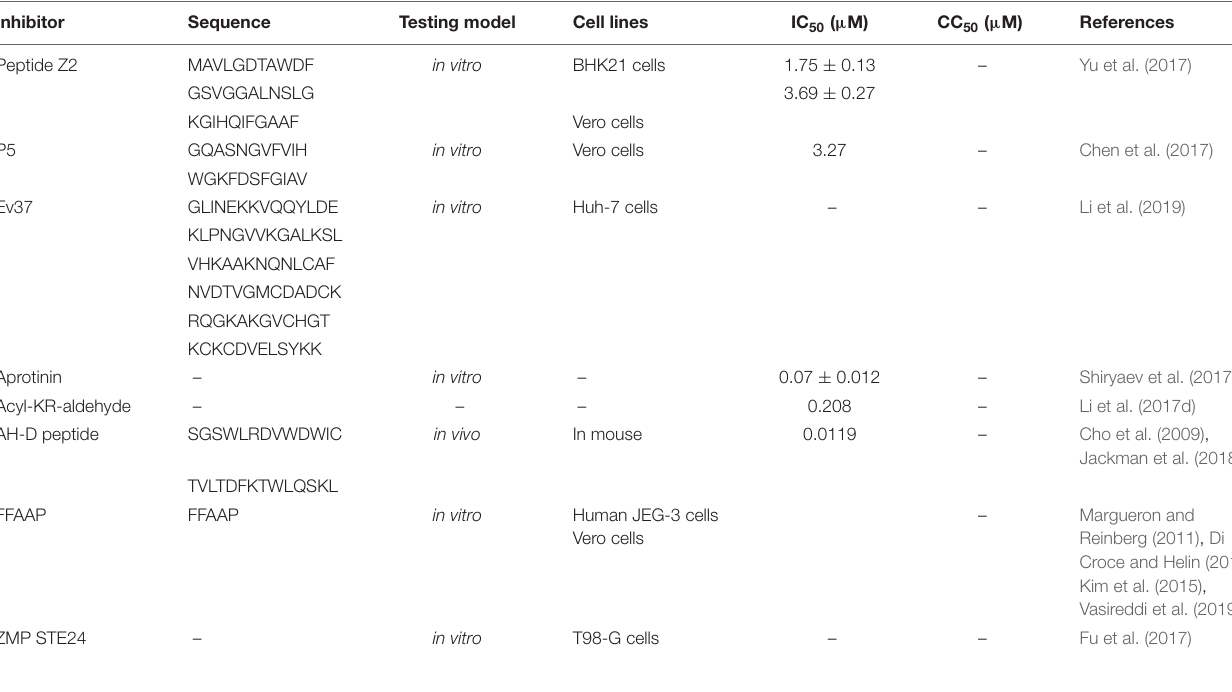
TABLE 1 | Zika virus peptide